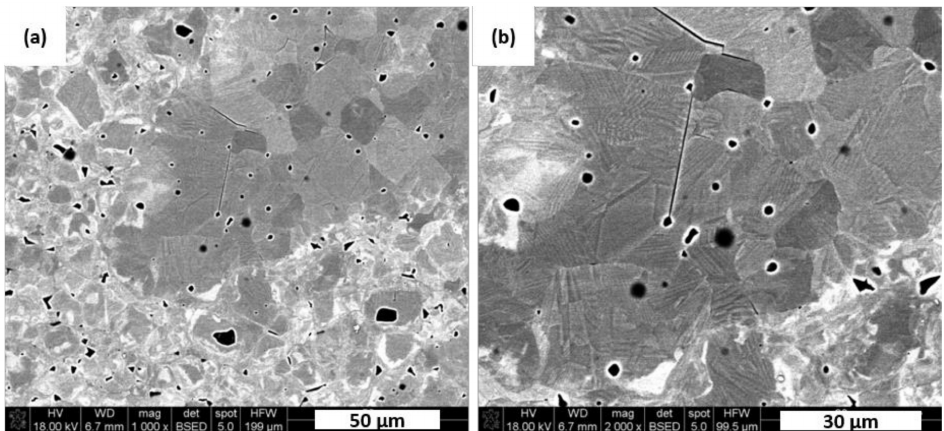
Figure 7. Microstructure domain of the N5E1 sample with 5% of Na 2 CO 3 and 1% of Er 2 O 3 addition